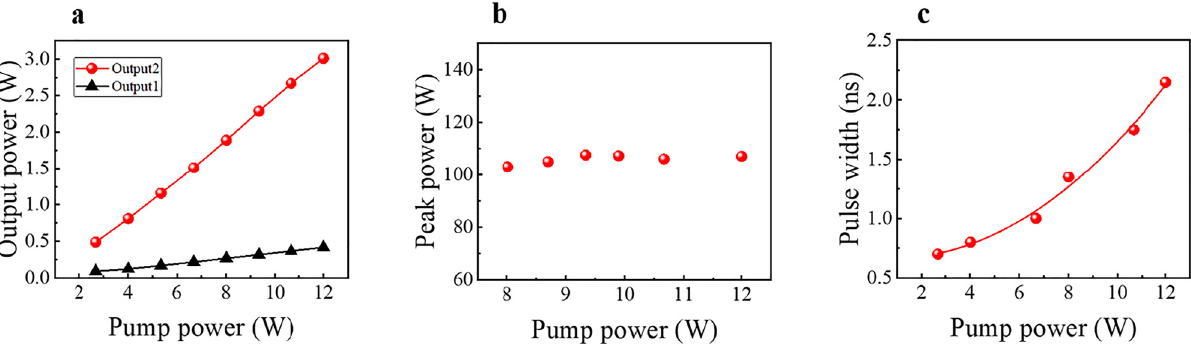
Figure 6: Intra-cavity DSR mode-locking output using the TAP-LPFG of (a) average output power, (b) peak power, and (c) pulse width as the function of pump power.